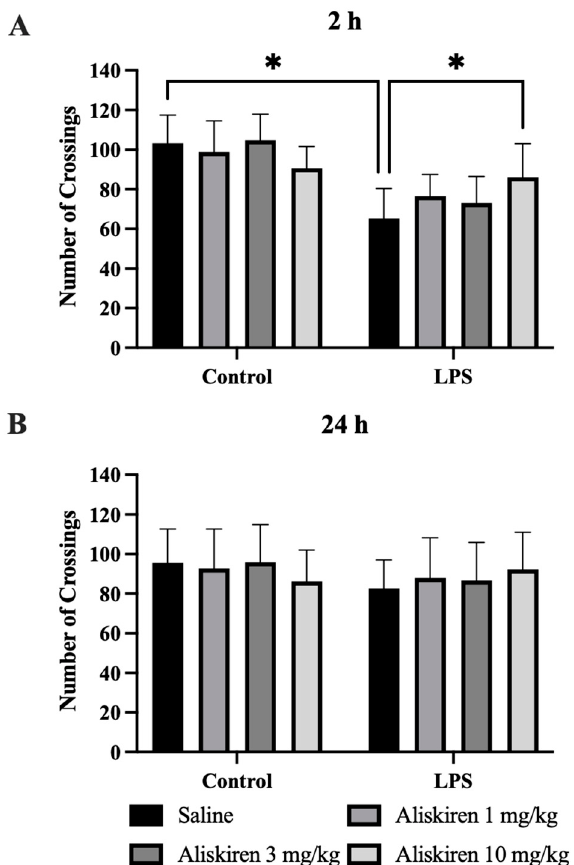
Figure 2. Assessment of Aliskiren Effects against LPS-Induced Sickness Behavior in Mice. ( A ) The effects of Aliskiren on the number of crossings in OFT two hours after LPS administration. ( B ) The effects of Aliskiren on the number of crossings in OFT 24 h after LPS administration. n ≥ 6 mice/group. * p < 0.05.